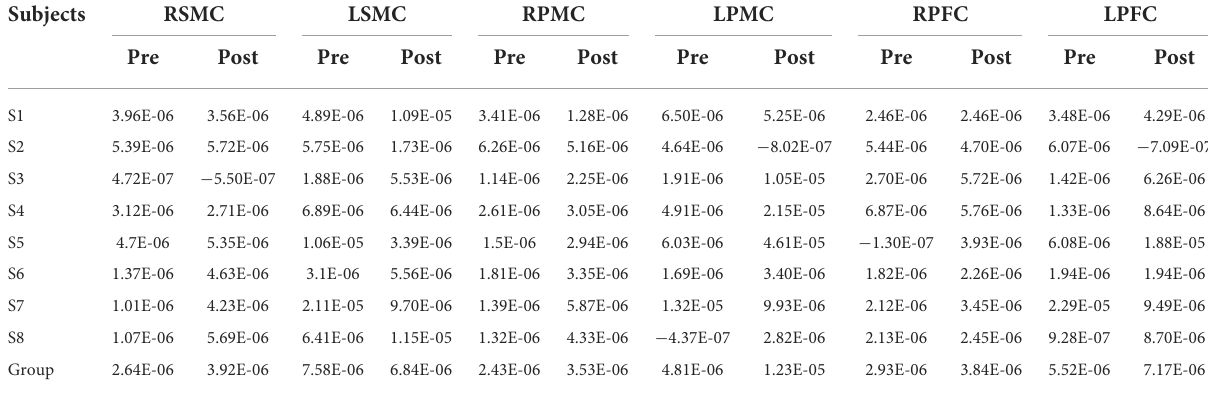
TABLE 5 The average individual and group Peak (mol/l) of all the subjects on 6 ROI pre and post intervention during grip-release ring task. Subjects